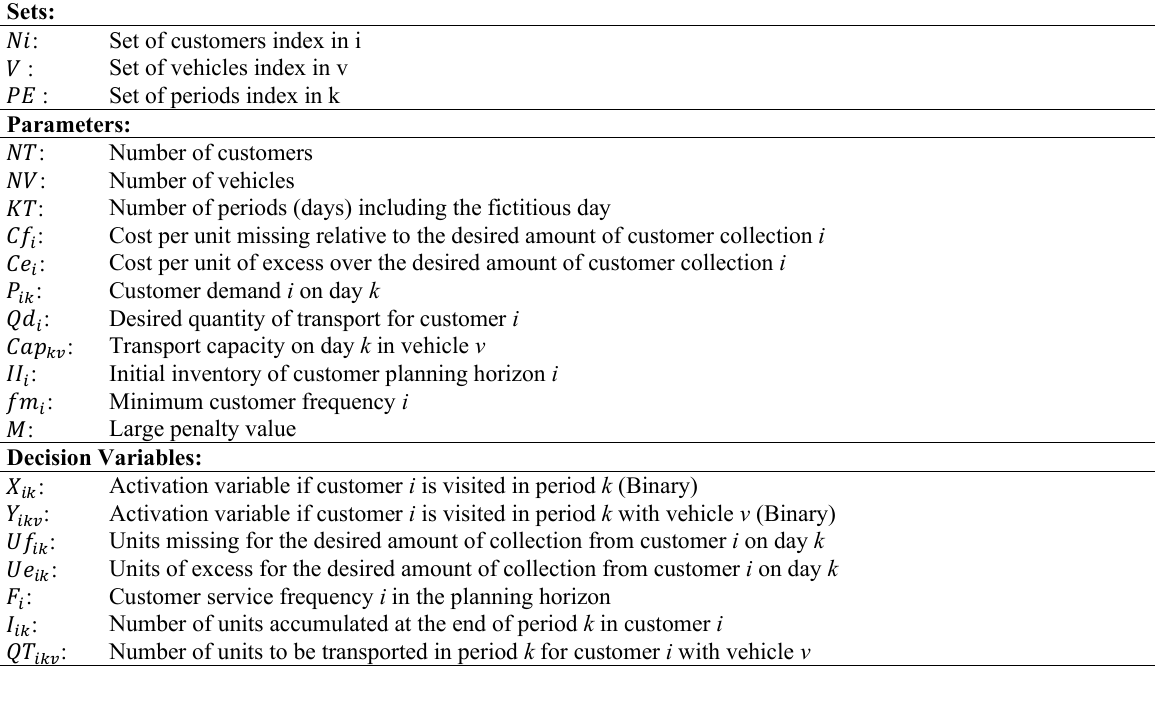
Notation used for allocation, clustering, and routing models